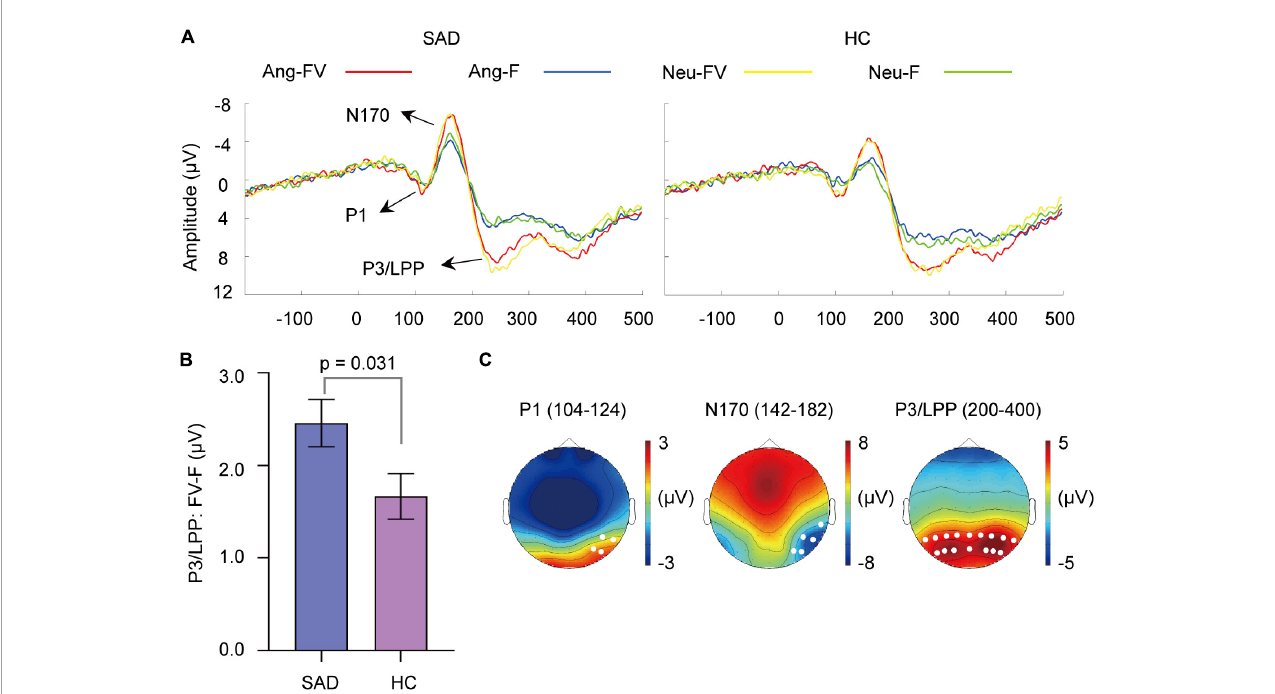
FIGURE4 Cross-modal enhancement of visual sensitive ERPs. (A) The grand-averaged waveforms of faces and bimodal combinations in angry and neutral trials for the SAD and HC groups. Ang-F, Ang-FV: Faces and bimodal combinations in angry trials separately; Neu-F, Neu-FV: Faces and bimodal combinations in neutral trials separately. (B) The mean amount of enhancement of P3/LPP amplitude by bimodal combinations than faces (FV-F) for the SAD and HC groups. Error bars indicate ± SEM. (C) The topographies of P1, N170, and P3/LPP and their corresponding time windows (ms) elicited by neutral faces for the SAD group as an example. The white dots indicate the representative electrodes of the